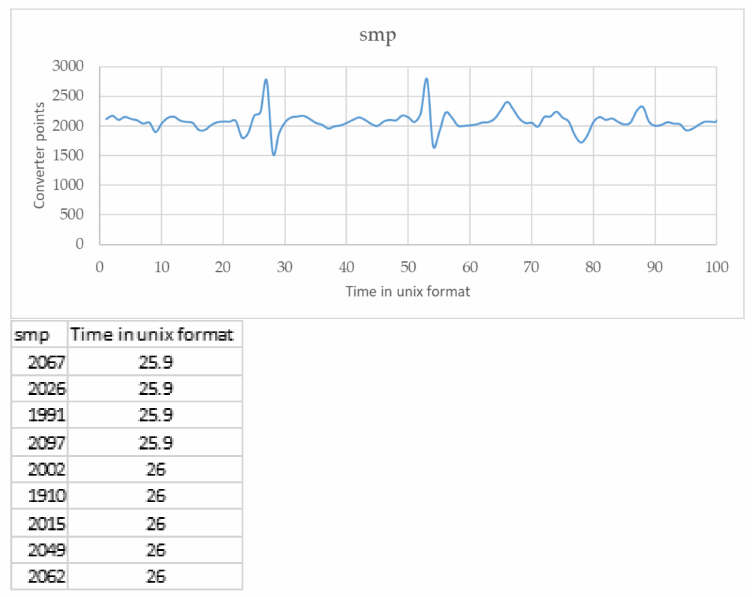
Figure 8. Example of graph and data outcome from geophones. The count starts at the Unix Epoch on 1 January 1970. Smp are the converter points, the number that the instrument gives, its analog